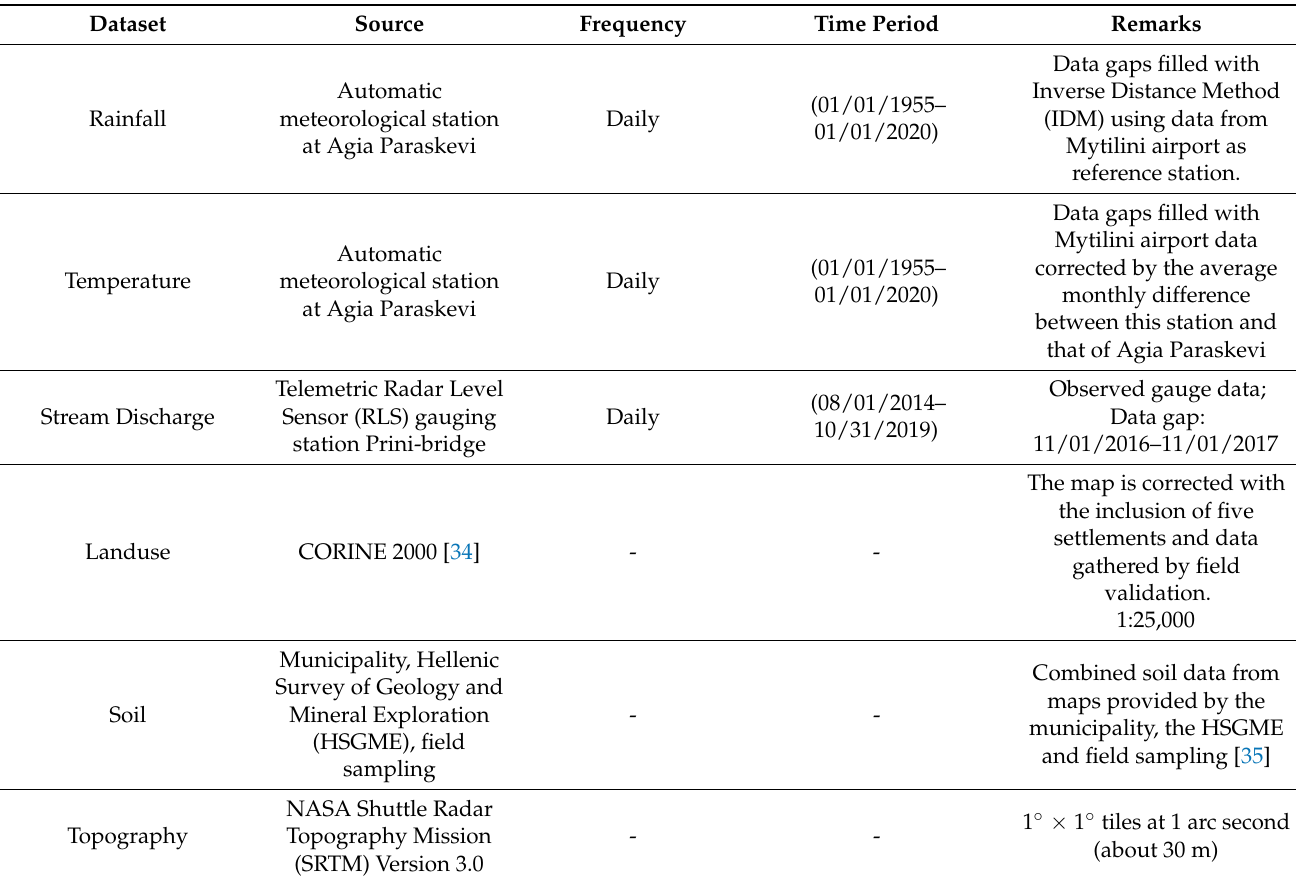
Table 1. Datasets used in the present